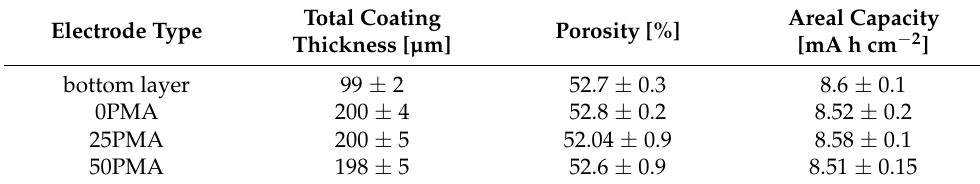
Table 2. Electrode parameters after coating, drying, and